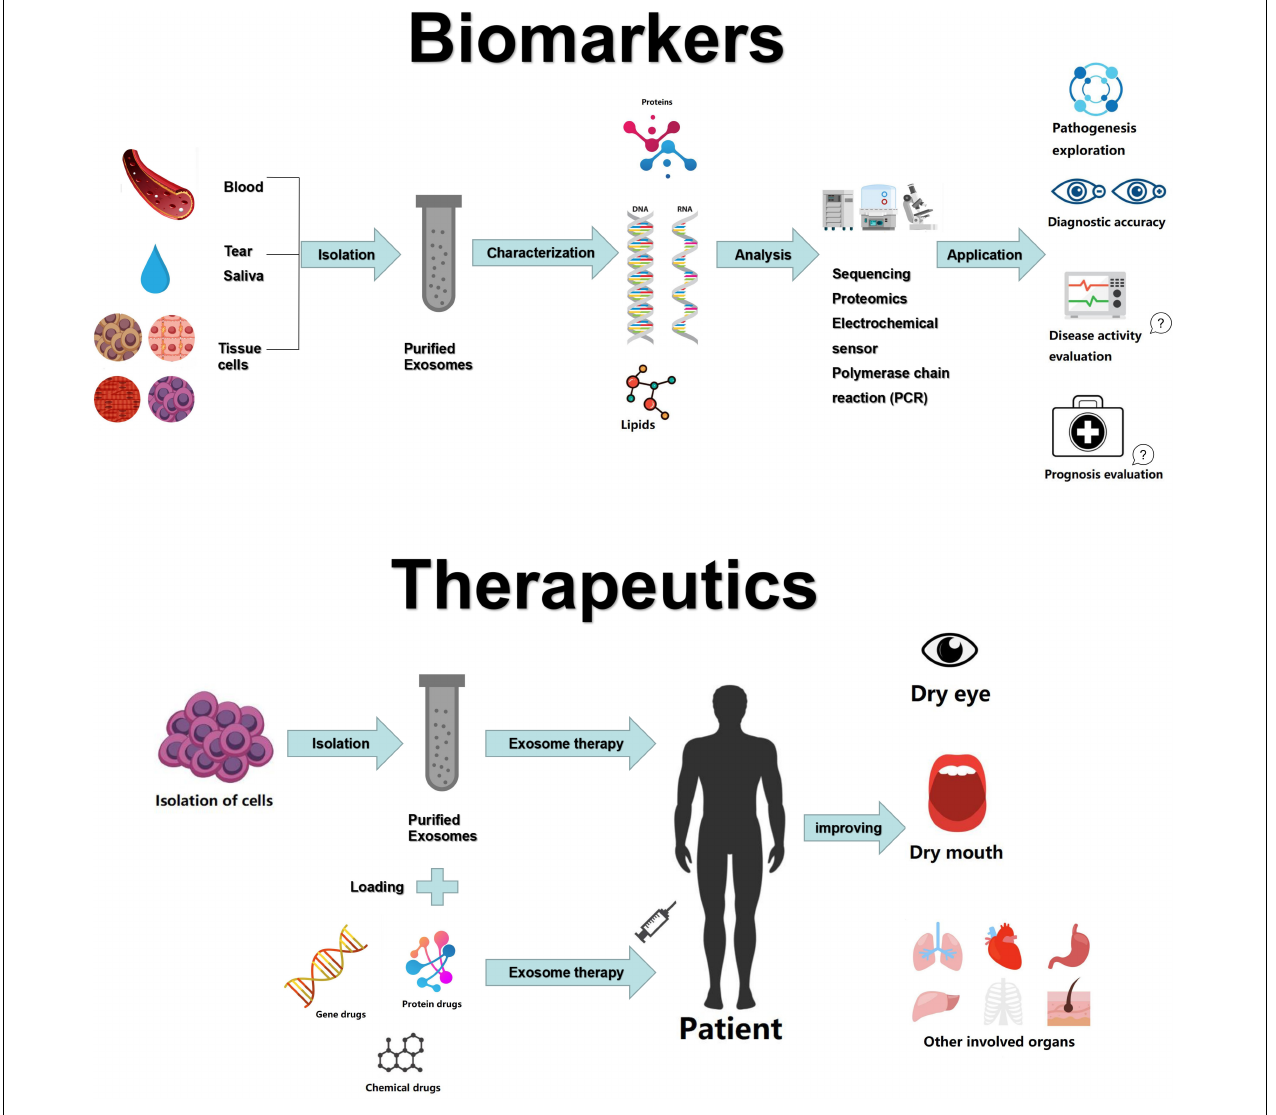
FIGURE 1 | Exosomes as biomarkers and therapeutic tools in Sjögren’s